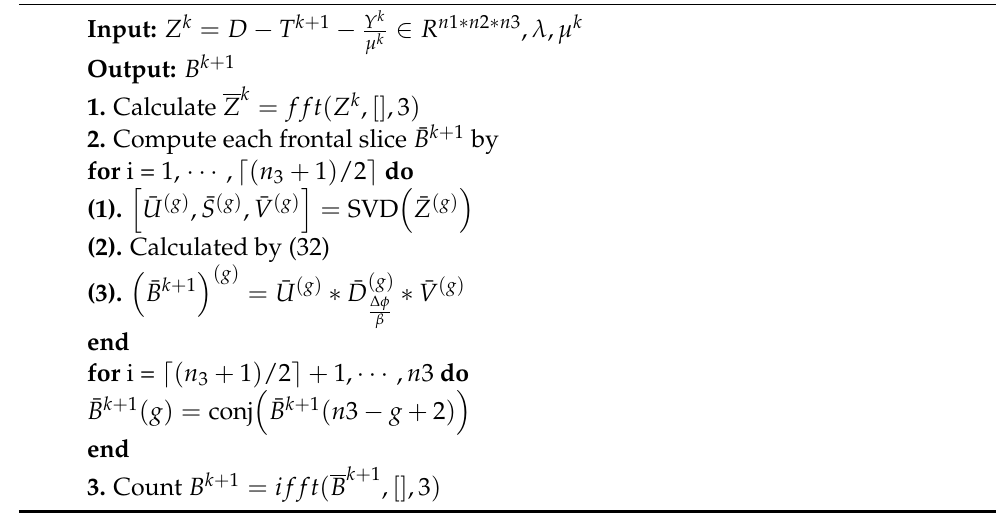
Algorithm 2: Optimization of problem (25).